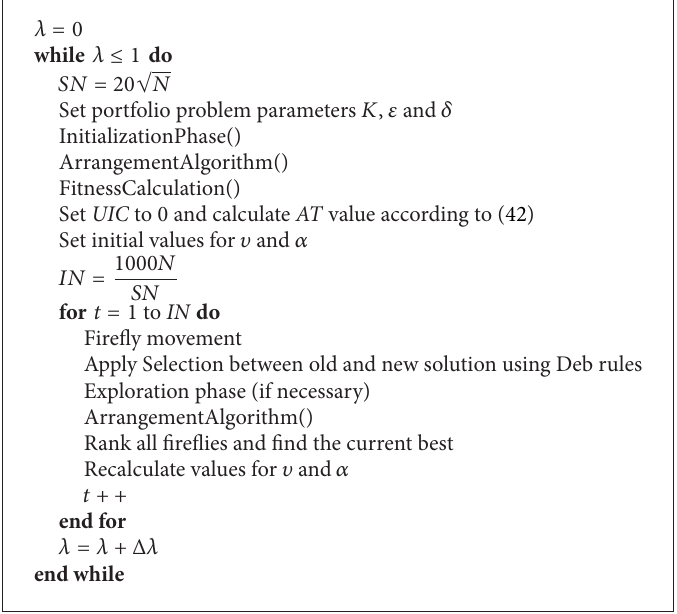
Algorithm 4: Modified firefly with